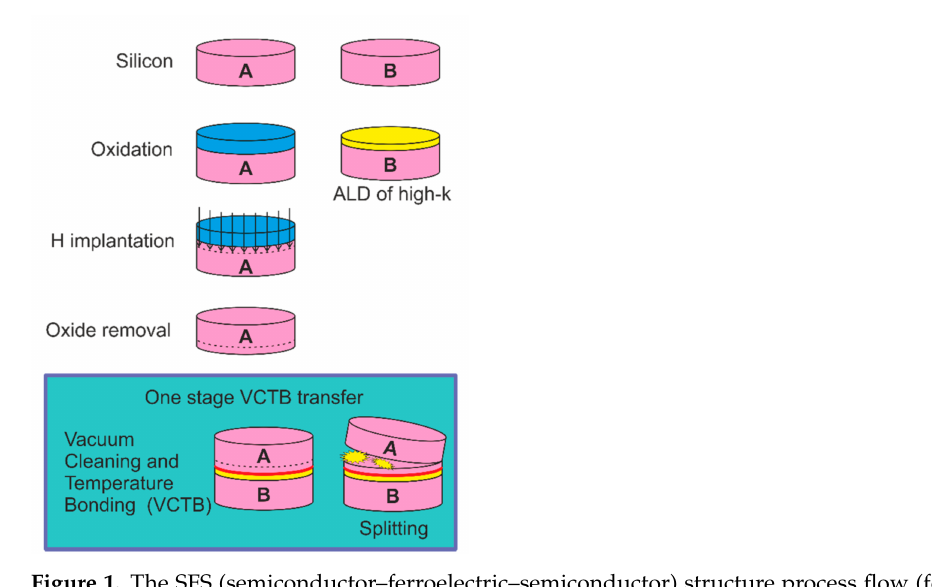
Figure 1. The SFS (semiconductor–ferroelectric–semiconductor) structure process flow (for more data see the